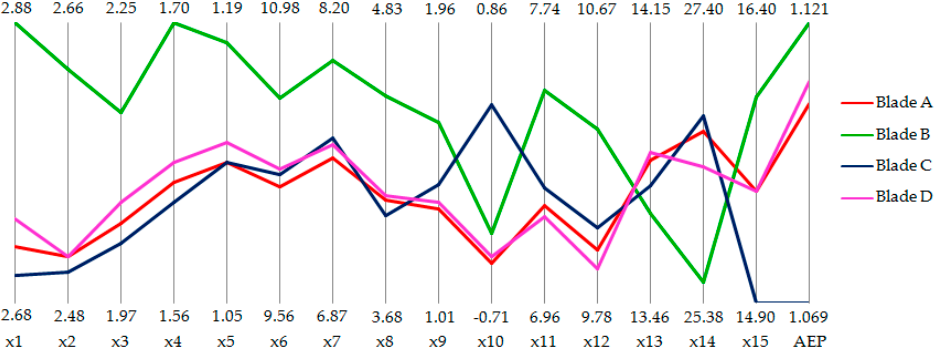
Figure 16. Aerodynamic variables of the extreme point design in parallel coordinates.